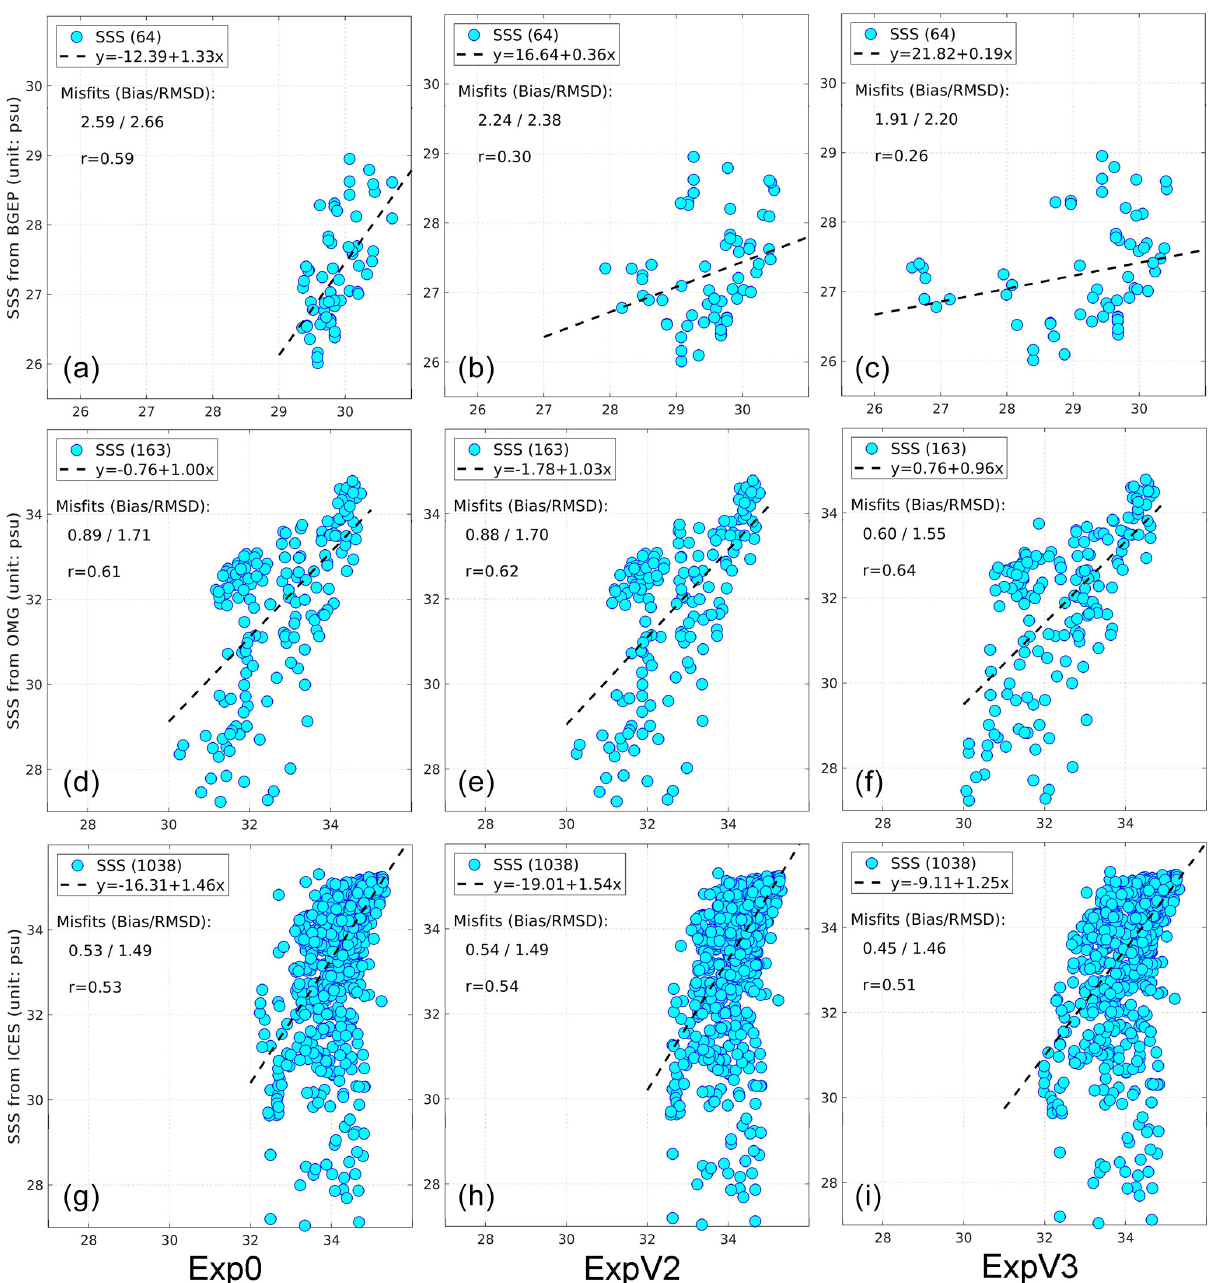
Figure 5. Scatterplots of SSS in the TOPAZ assimilation runs against in situ profiles (top: from BGEP in the Beaufort Sea; middle: from OMG in both Greenland seas; bottom: from ICES in the Nordic Seas, as indicated in Fig. 1 and descriptions in Sect. 3). The statistics of SSS misfits are indicated in each panel with the bias and the RMSD, respectively; the number of observations is given between parentheses. The dashed dark line represents the linear regression, and r is the linear correlation coefficient. All the correlation coefficients are over the 95% significance